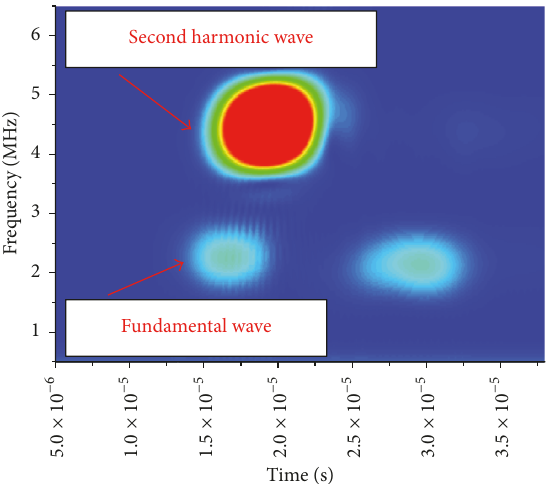
Figure 9: Relationship between nonlinearity parameter and fatigue